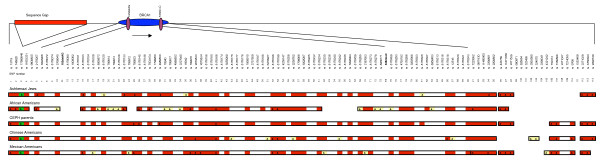
Comparison of haplotype blocks at 114 loci across five populations. Blocks were defined as in [27]; markers with MAF <0.05 are shown with a white background and were ignored in the calculations and block boundary estimation. Haplotype tag SNPs (htSNPs) within a block are indicated by arrowheads; htSNPs in only one population are shown on a yellow background while the single htSNP shared between all populations is shown on a green background.